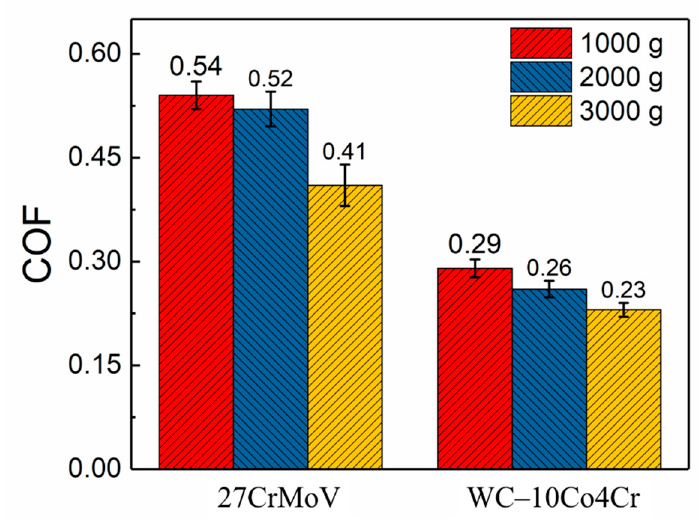
Figure 9. The average coefficient of friction after the running-in stage of the 27CrMoV substrate and WC–10Co4Cr coatings at different loads.